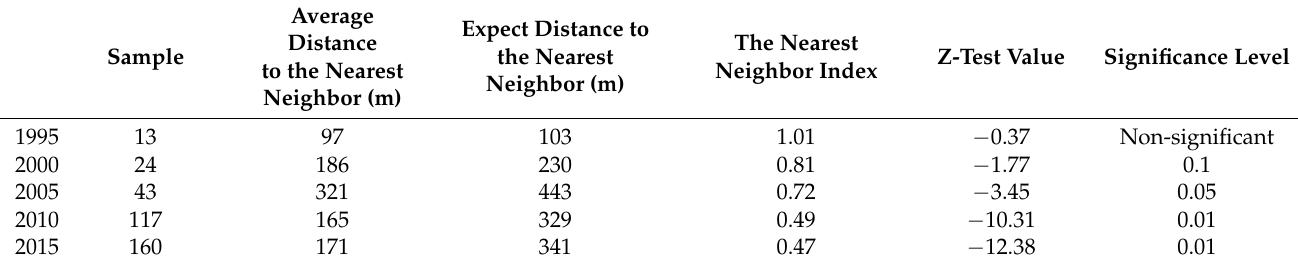
Table 3. The nearest neighbor index (NNI) of luxury